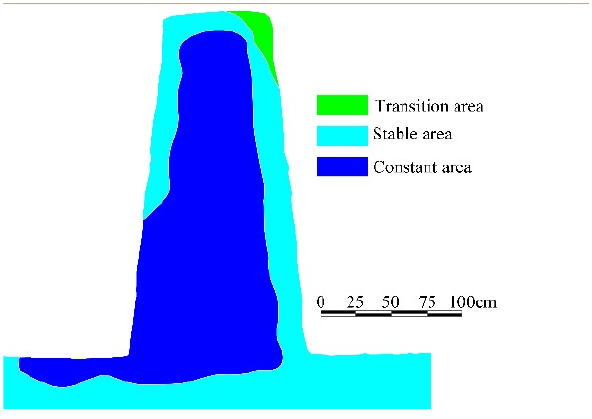
Figure 18. Temperature field of test wall in winter.